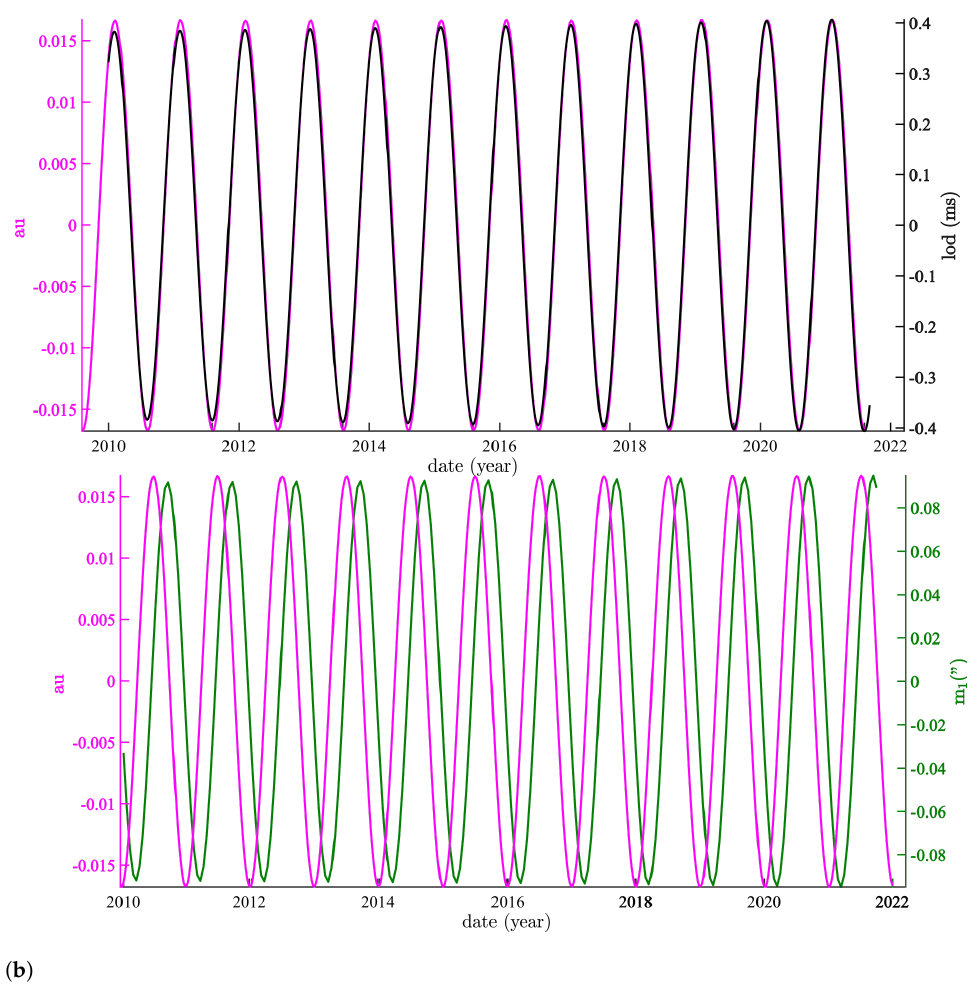
Figure 6. Variations in the Earth-to-Sun distance D SE (in au; purple) compared to the first (annual) SSA component of m 1 ( bottom ) and the lod ( top ). In the middle curve, lod is offset by 152.5 days.